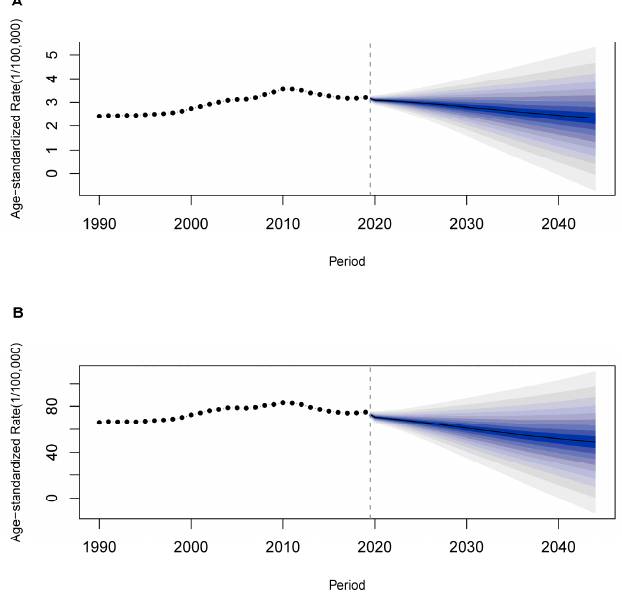
Figure 4. The temporal trends of ASMR and ASDR for lung cancer that can be attributed to occupational carcinogens between 1990 and 2044 in China. The predictive mean is shown as a solid line. The dotted line represents the observational values from the GBD dataset. The vertical dashed line indicates where the prediction starts. The predictive mean value is shown as a black solid line. The fan shows the predictive distribution between the 5% and 95% quintiles, whereby the shaded bands show prediction intervals in increments of 10%. ( A ) ASMR. ( B ) ASDR.